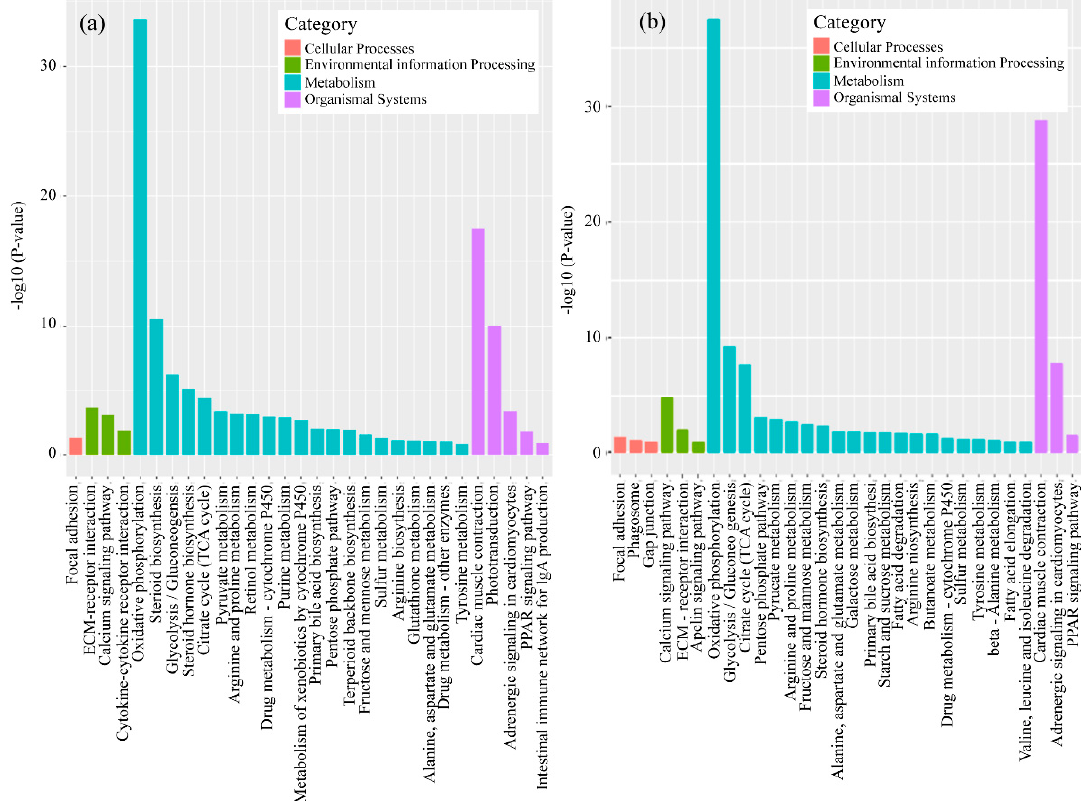
Figure 5. The top 20 enriched Kyoto Encyclopedia of Genes and Genomes (KEGG) pathways in the erythromycin-treated groups and the control group ( a ) D. rerio , ( b ) O. latipes